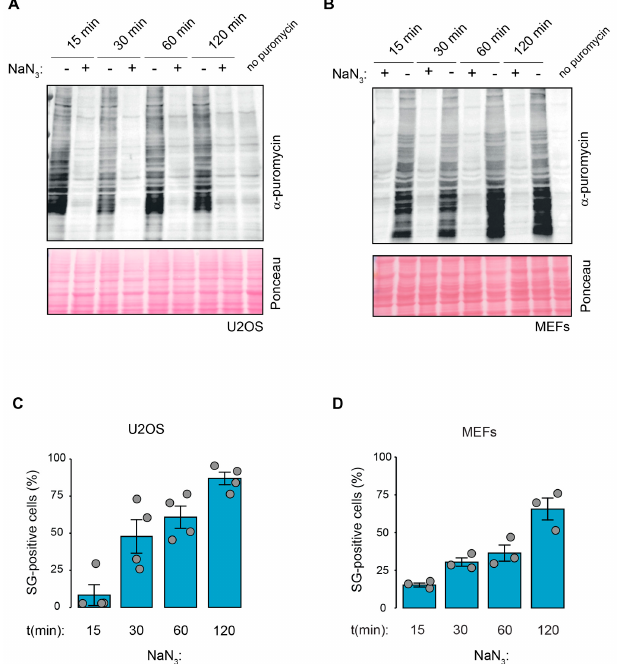
Figure 3. Kinetics of the NaN 3 -induced SG response and translation inhibition. ( A , B ) Protein synthesis in U2OS cells ( A ) and MEFs ( B ) exposed to NaN 3 (76 mM) was measured at different time points upon NaN 3 addition using a WB-based puromycin incorporation assay. Ponceau staining served as the loading control. As a control, a sample without puromycin labeling was also loaded. ( C , D ) U2OS cells ( C ) and MEFs ( D ) were treated with NaN 3 (76 mM) at different time points as indicated. Cells were fixed, stained against G3BP1 and analyzed using IF. The number of SG positive cells was quantified using visual inspection. The graphs show the mean value ± SD ( n ≥ 3 independent experiments; approximately 100 cells were analyzed per experiment and condition).